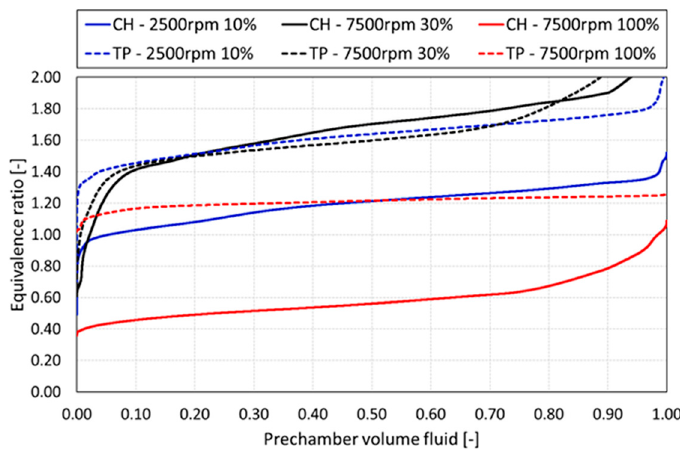
Figure 23. Fuel homogenization inside the PN6 prechamber at 360 °CA: comparison between CH injection (continuous lines) and TP injection (dashed lines).